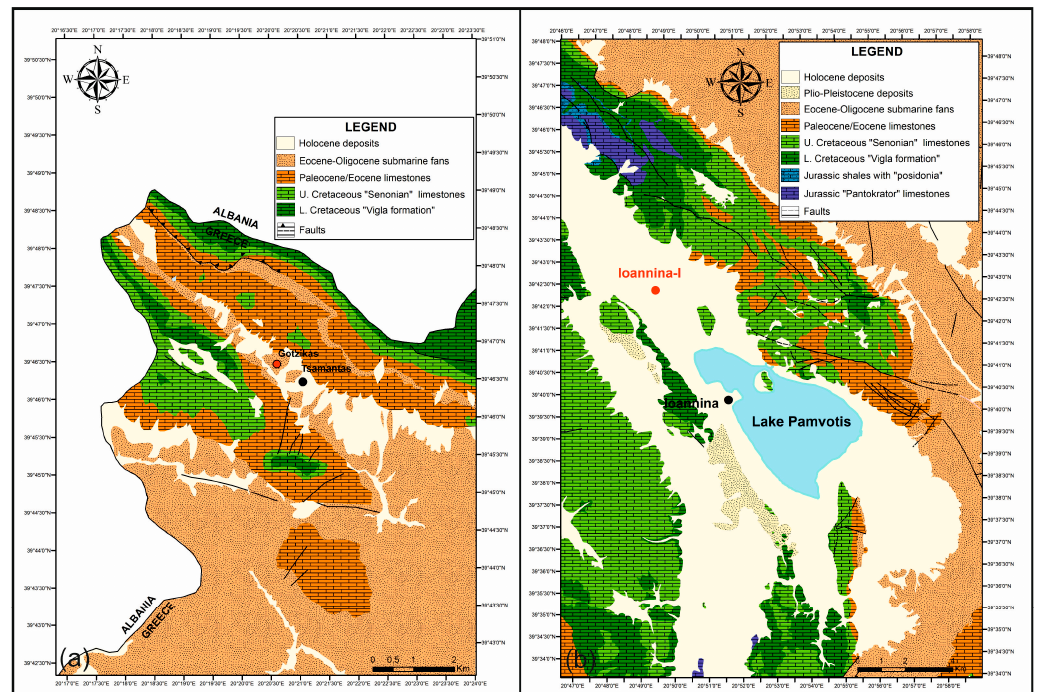
Figure 6. ( a ) Geological map of the area around the Gotzikas section. Red circle marks the position of the studied section. ( b ) Geological map of region around Ioannina area. Red circle marks the position of Ioannina well.